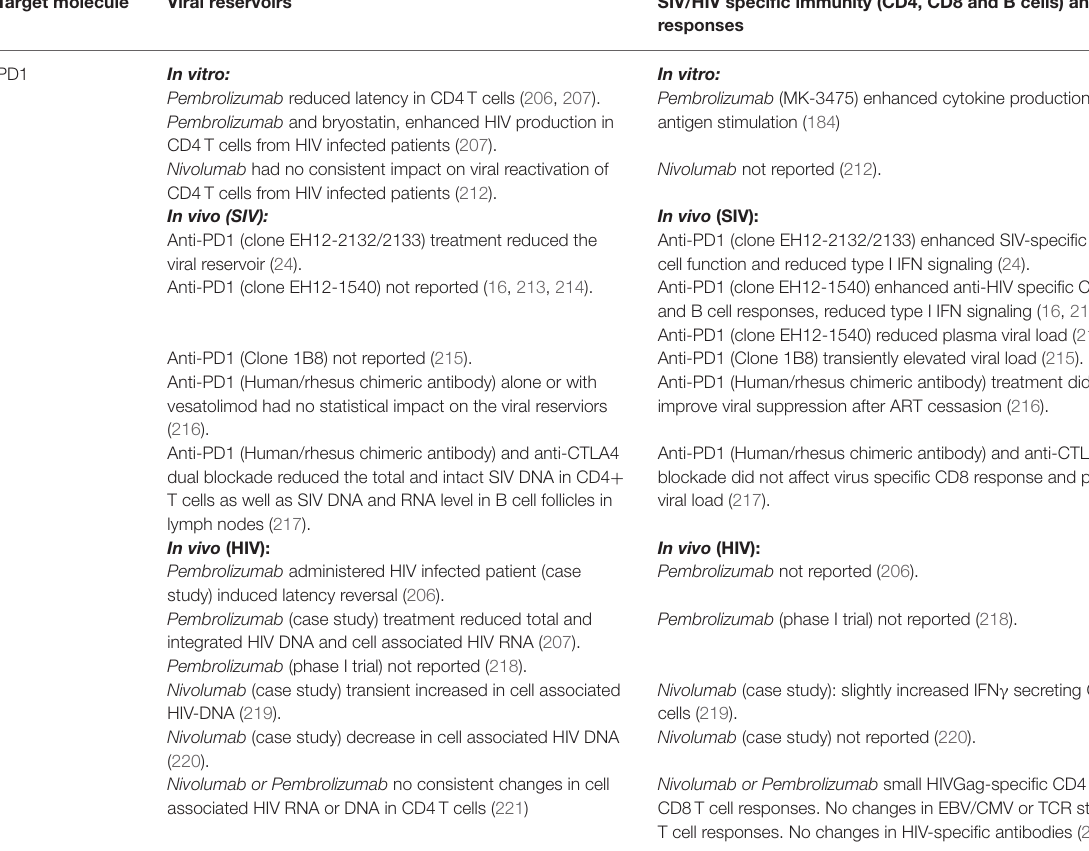
TABLE 1 | Effects of immune checkpoint receptors blockade in SIV/HIV specific responses. Target